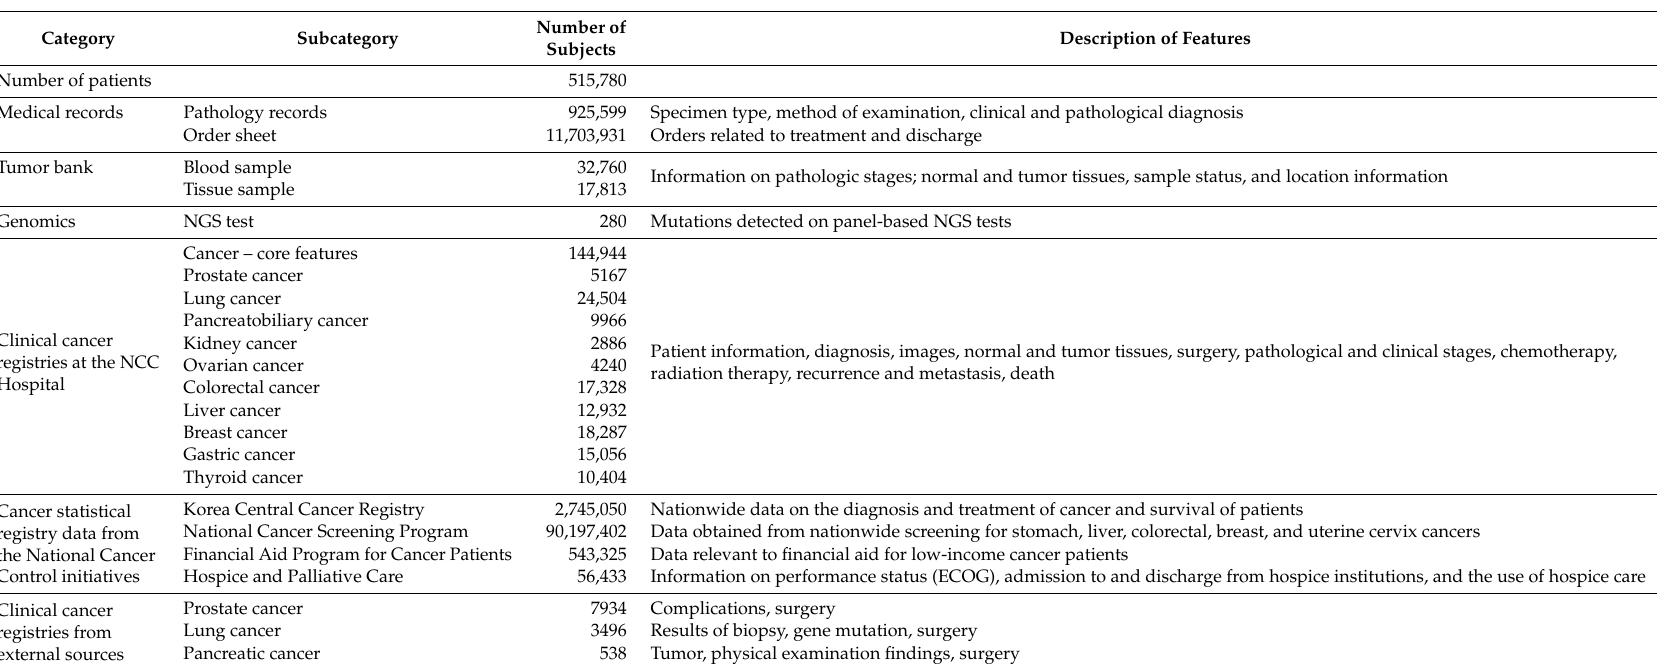
Table 1. Number and type of items integrated in the Korea Cancer Big Data Platform